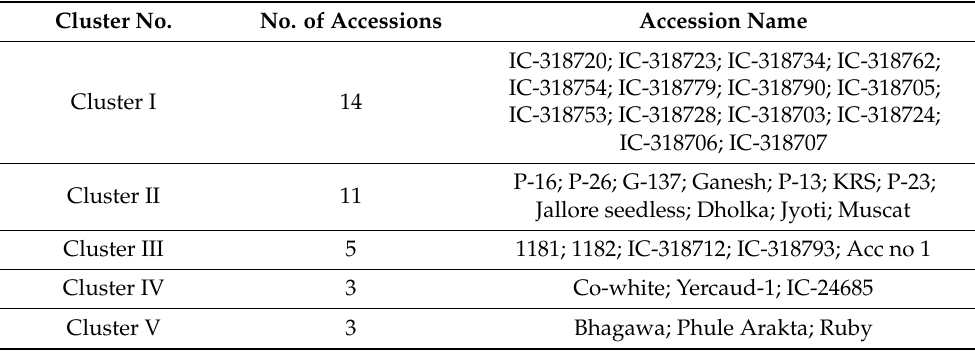
Table 2. Grouping of pomegranate accessions based on Tocher’s clustering method applied to the pairwise Mahalanobis D 2 distance calculated using the morphological data. Cluster